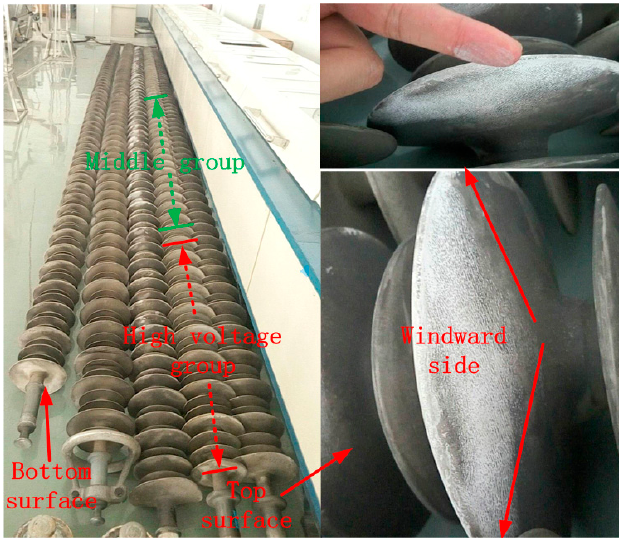
Figure 2. Field pollution test of transmission line operating insulators.